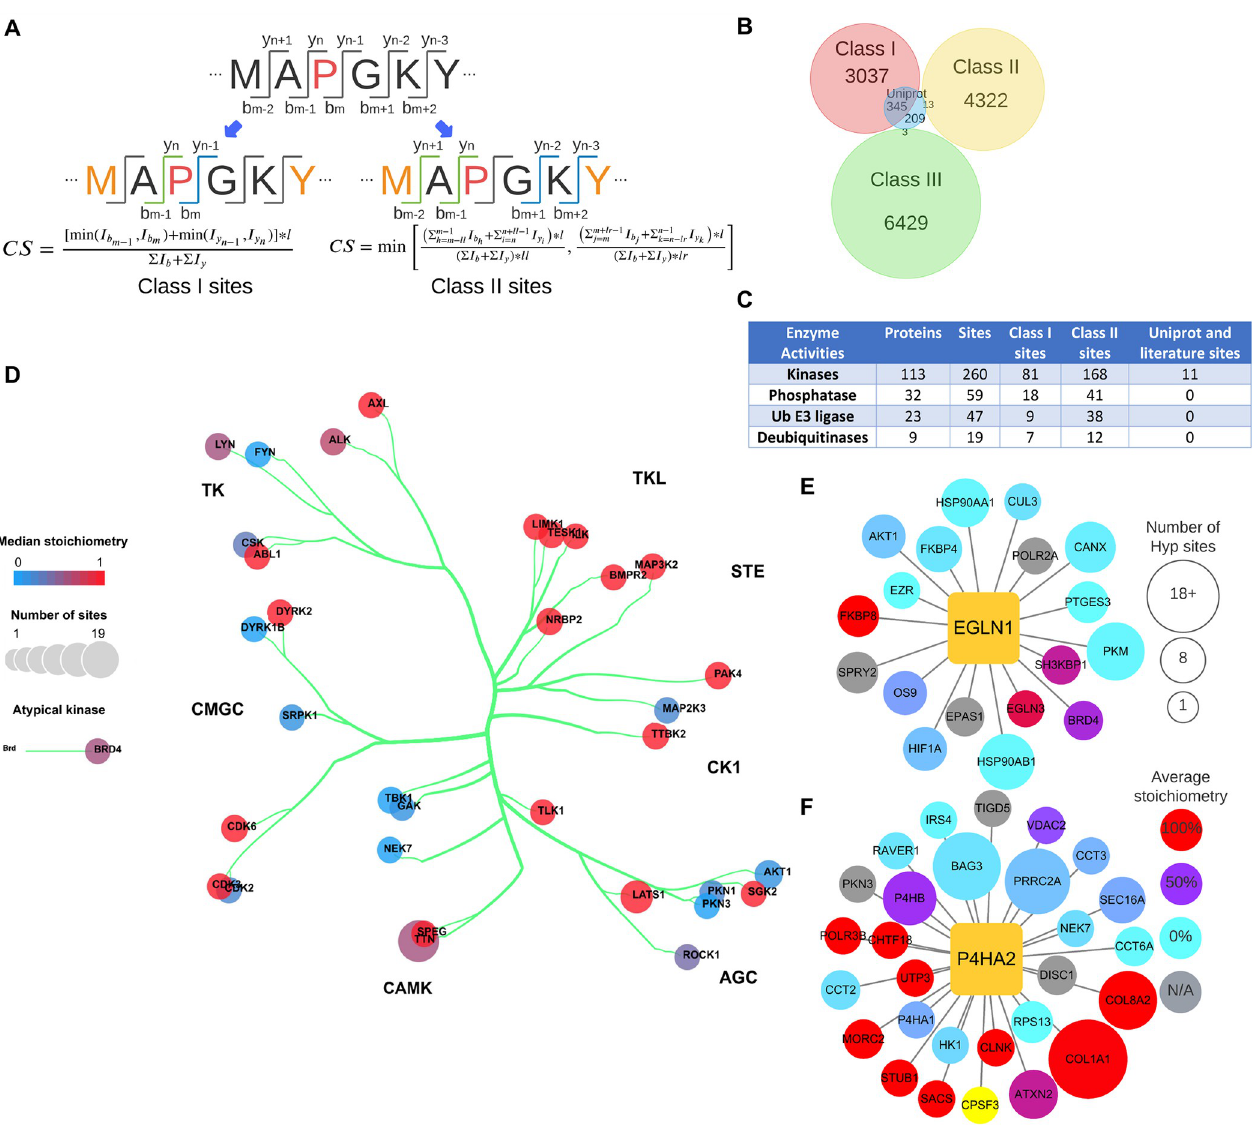
Fig 2. Substrate diversity of the human Hyp proteome. (A) Illustration of classification-based algorithm to identify confident Hyp sites. (B)Venn diagram of Class I, II, III Hyp sites identified from MS analysis and manually curated UniProt sites. (C) PTM regulatory enzymes identified as Hyp substrates. (D) Kinase tree classification showing the distributions of kinases as Hyp substrates in different kinase families, including AGC (named after PKA, PKG, PKC families), CAMK (leaded by calcium/calmodulin-dependent protein kinases), CK1 (cell kinase 1), CMGC (named after CDKs, MAPK, GSK, CLK families), STE (homologs of the yeast STE counterparts), TK (tyrosine kinases), and TKL (tyrosine kinase-like). (E) Hydroxyproline proteins that interact with EGLN1. (F) Hydroxyproline proteins that interact with P4HA2. Refer to Sheet A in S2 Table and Sheet A–G in S3 Table for the underlying data of Fig 2B–2F. Hyp, proline hydroxylation; PTM, posttranslational